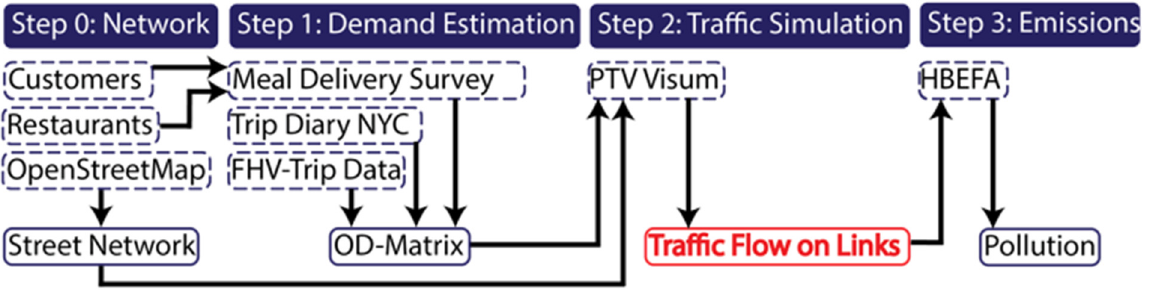
Figure 9. Study methodology (On-demand meal delivery